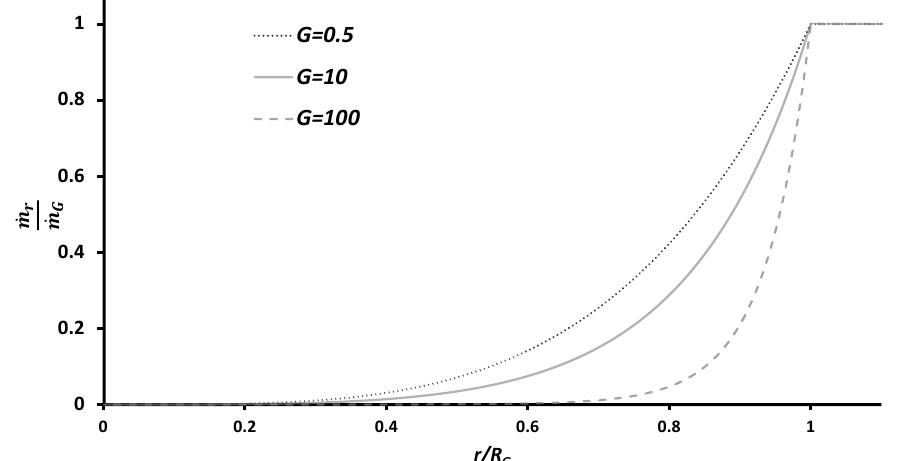
Figure 5. Plot of normalized radial mass flow rate ( ˙ m r / ˙ m G ) against the normalized radius ( r / R G ) for different group combustion numbers ( G